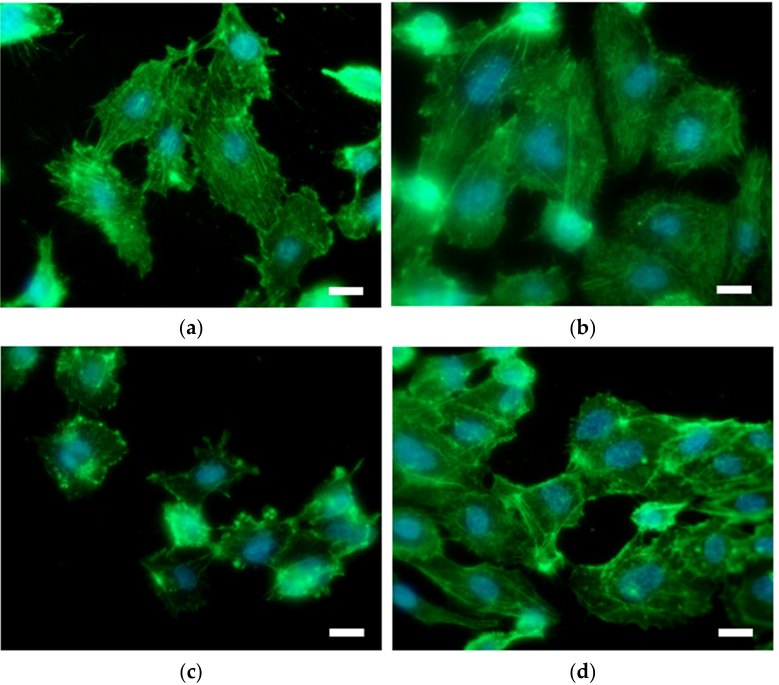
Figure 5. EC on the surface of ( a ) Ti foil, ( b ) plasma-treated Ti foil (Ti + P), ( c ) hydrothermally treated Ti foil (Ti HT) and ( d ) hydrothermally/plasma-treated Ti foil (Ti HT + P) determined by immunofluorescent microscopy. F-actin is shown in green (Fluorescein Phalloidin). Nuclei are visualized with DAPI (blue color). Scale bar = 25 µm.